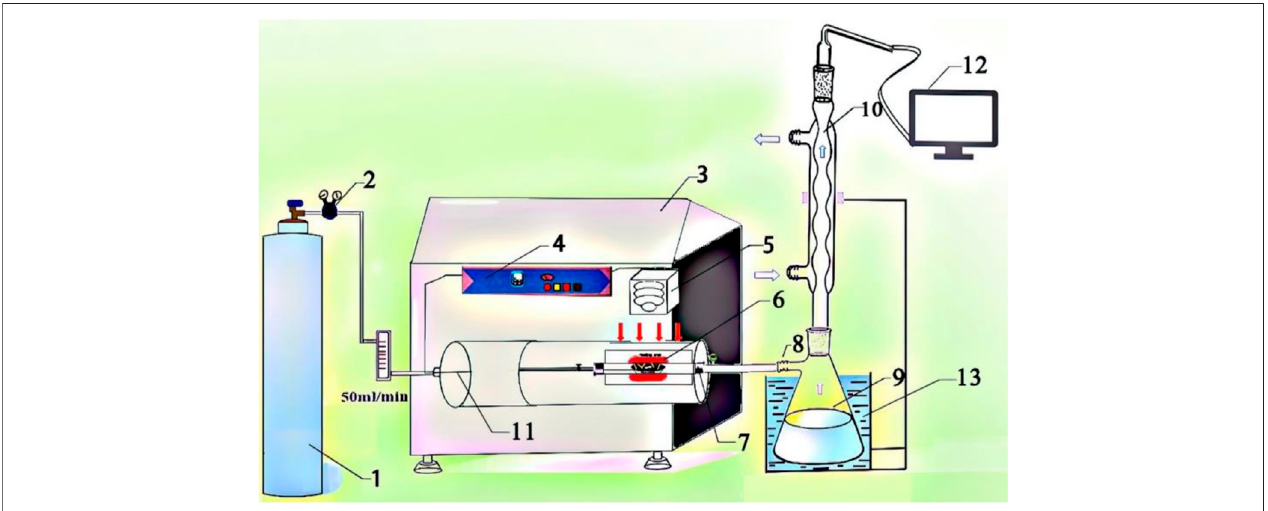
FIGURE 1 | Schematic diagram of the microwave-assisted pyrolysis setup: (1) nitrogen cylinder; (2) cylinder valve; (3) microwave reaction equipment; (4) control panel;(5)thermocouple;(6)crucible(speci fi cformicrowaveheating);(7)thermalinsulationposition;(8)rubbertube;(9)bio-oilcollectionbottle;(10)condensingtube;(11) temperature probe; (12) gas chromatograph; (13) cooling